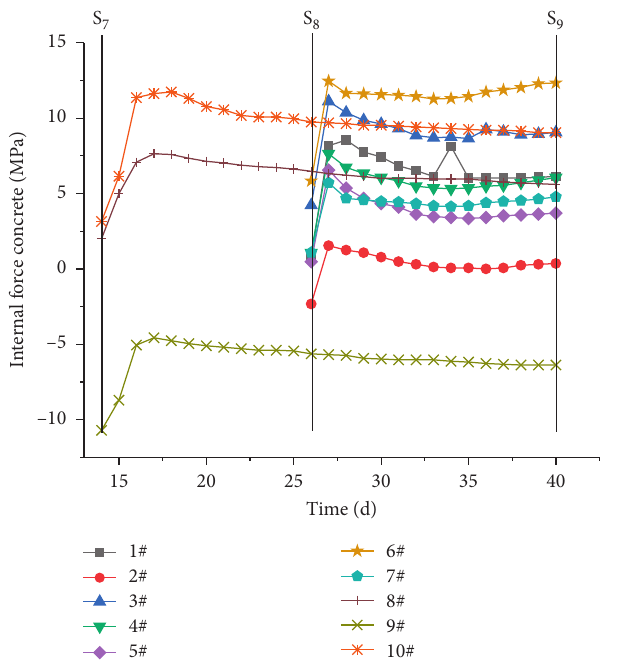
Figure 15: DK-190+617 mileage concrete internal force change curve of Zaosheng Tunnel.